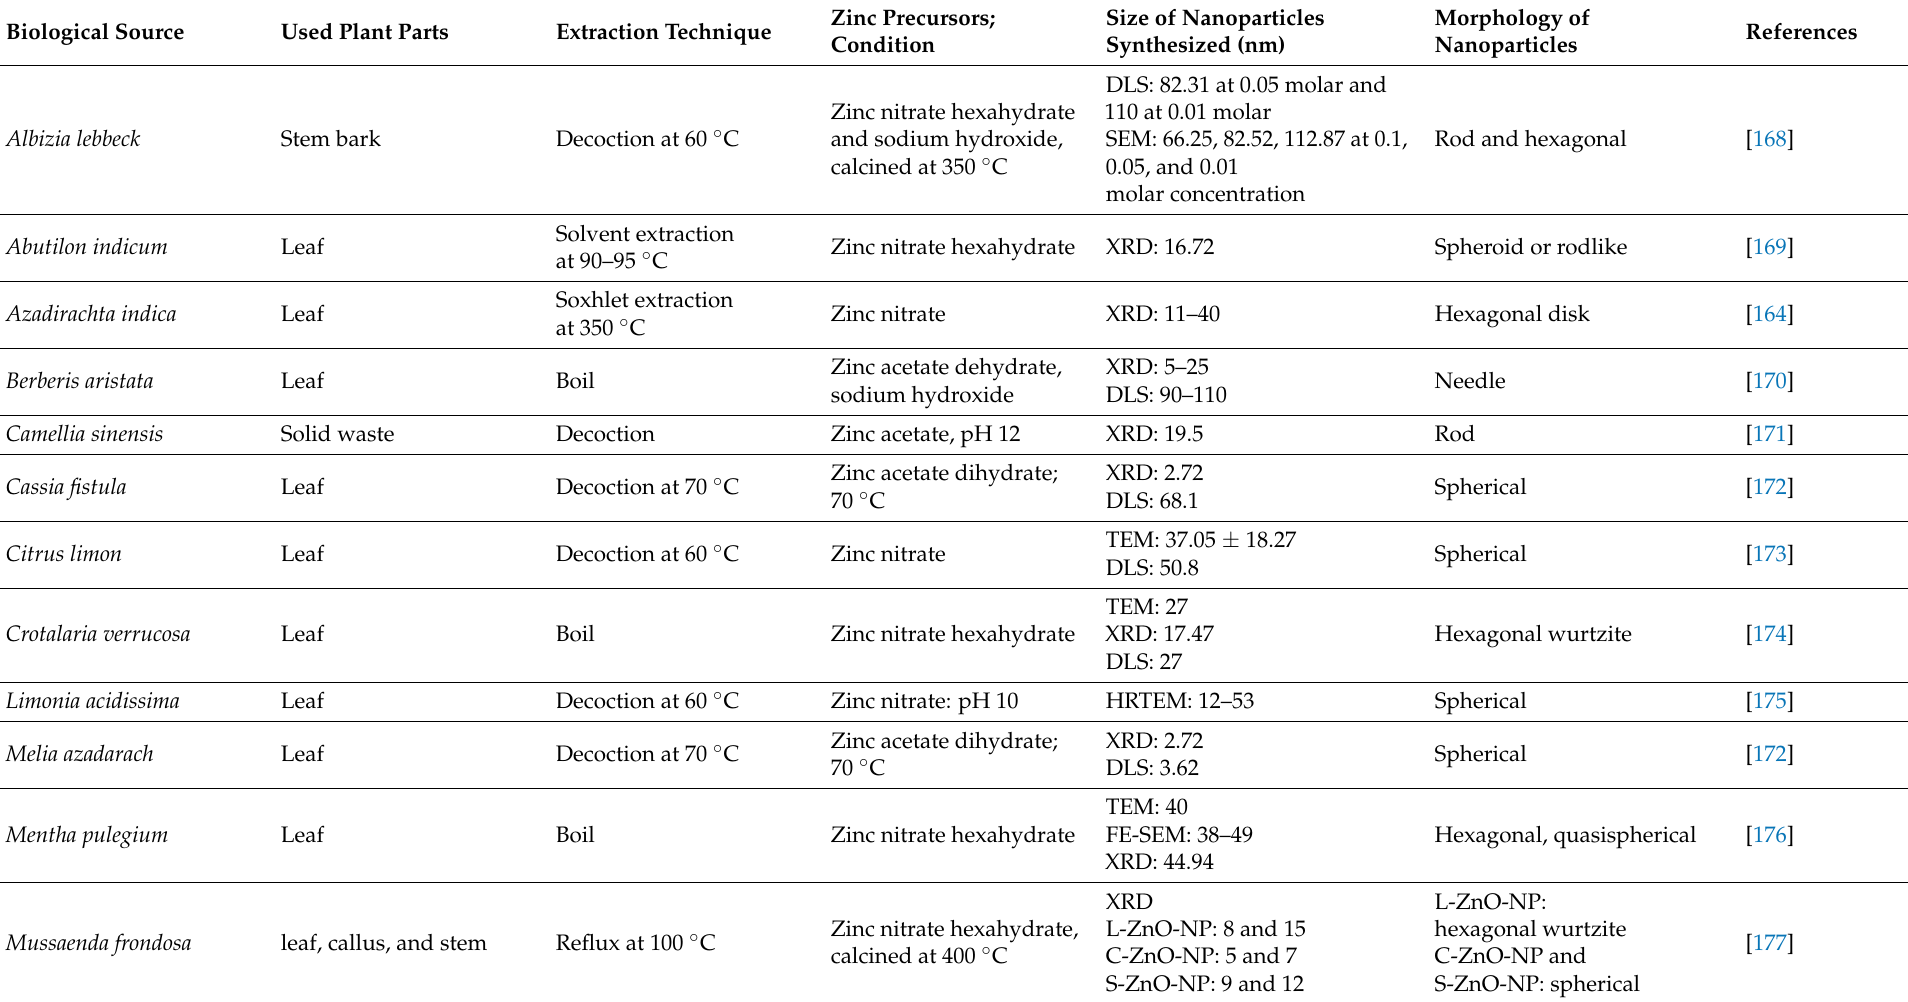
Table 1. Summary of the plant-mediated synthesis of zinc oxide